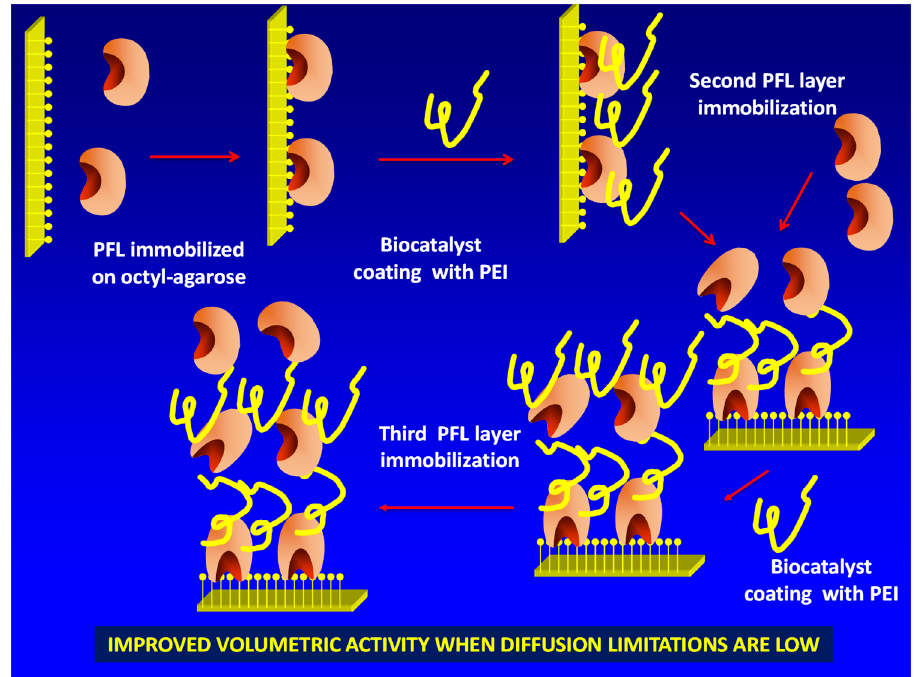
Figure 1. Scheme of the multilayer immobilization strategy proposed in this paper. PEI: polyethylenimine; PFL: lipase from Pseudomonas fluorescens.